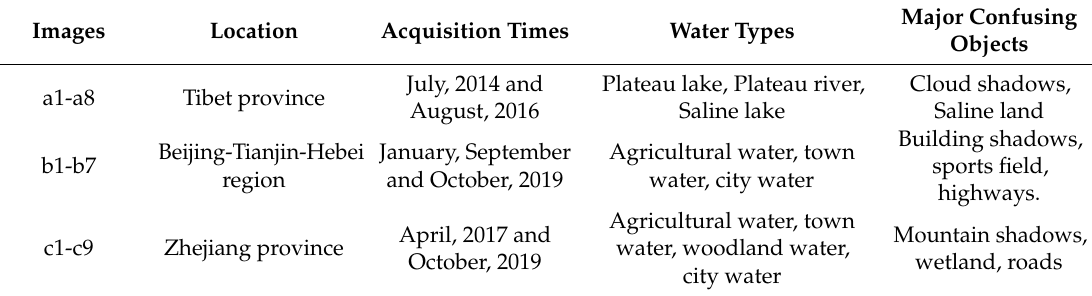
Table 1. Detailed information of